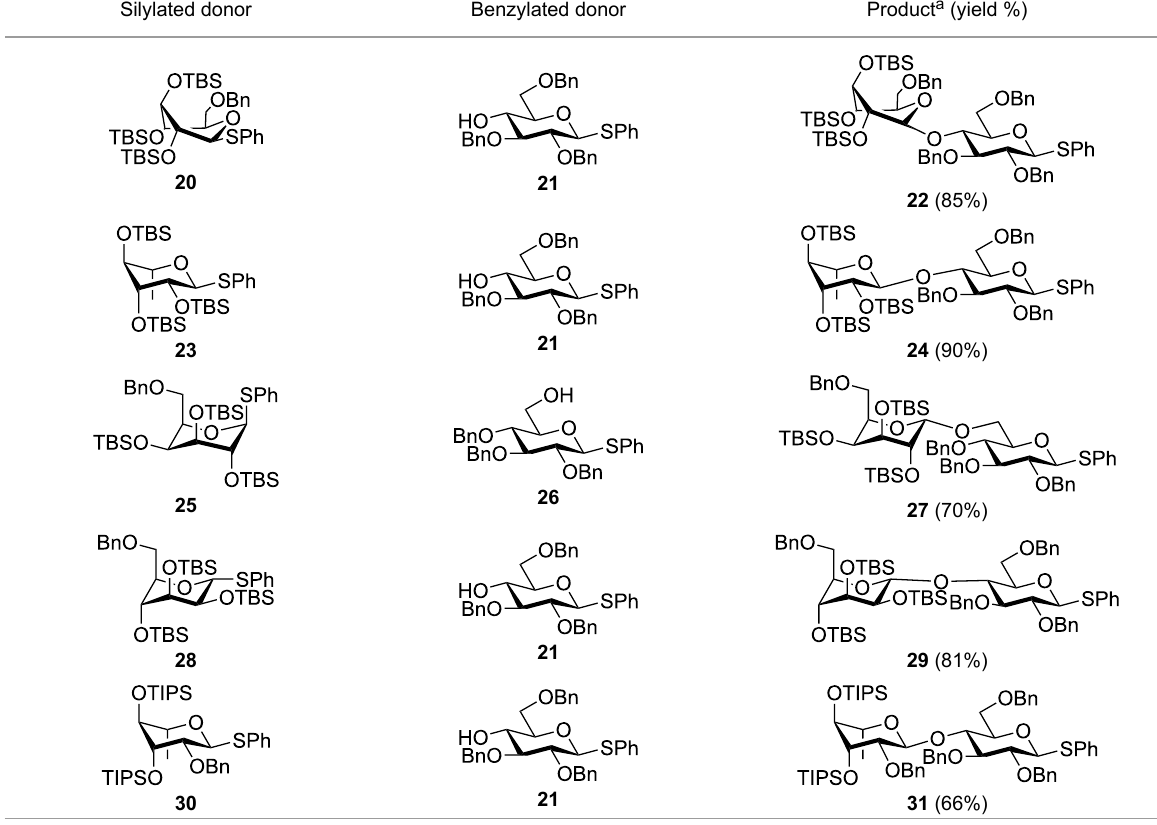
Table 1: Reaction of silylated thioglycosides with benzylated thioglycoside